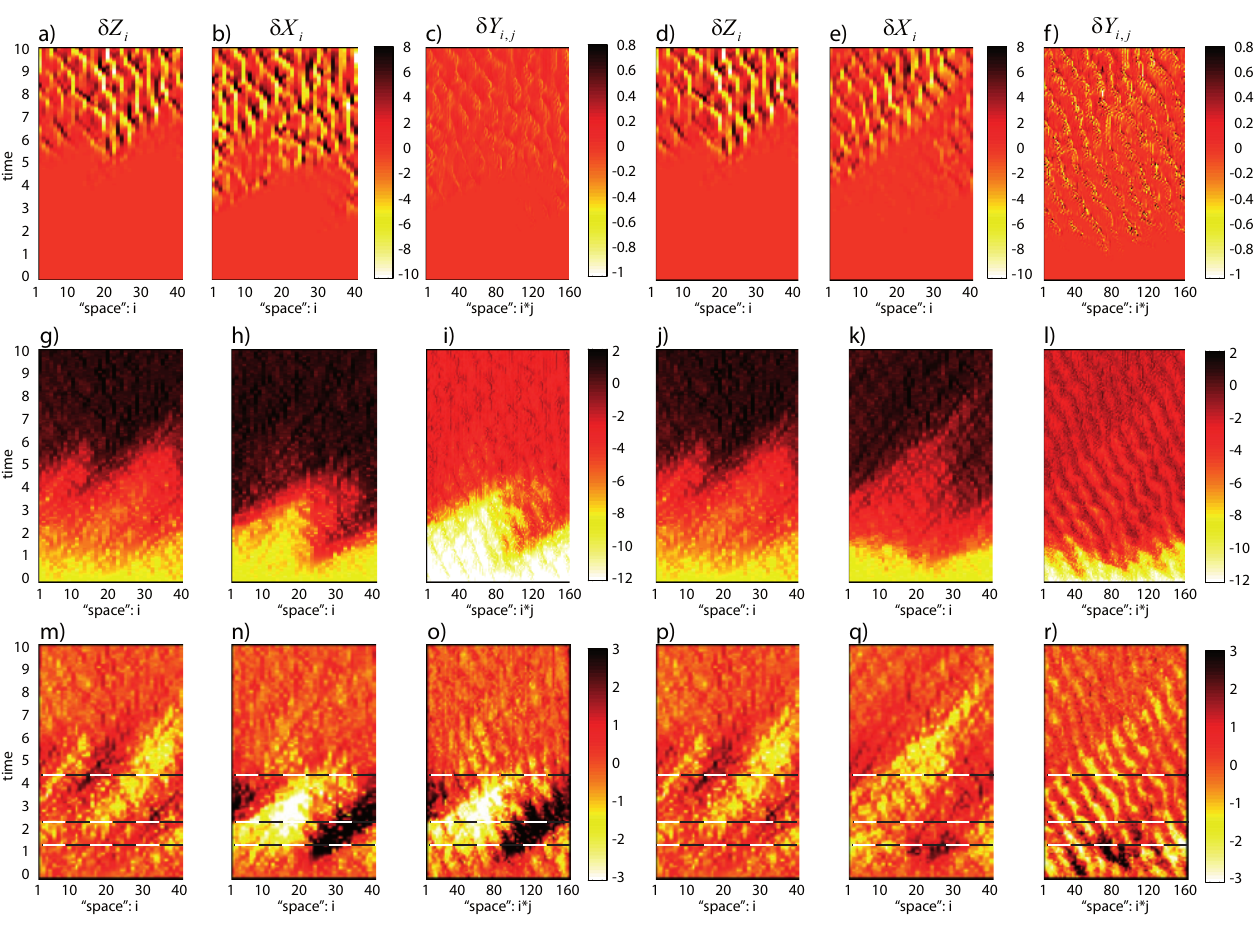
Fig. 3. Upper row: dynamics of a single realization of perturbations of the initial condition for (a, d) the simplified L96 model, and (b, c) the slow-fast variables, δx i and δy j,i of the L96 model with weak coupling h =0.3 and (e, f) with strong coupling h =1. The initial perturbations were randomly chosen according to a Gaussian distribution with standard deviation σ for δz and δx , and 0 for δy . Middle row: the same as in the upper row but in logarithmic scale. Lower row: the same as in the middle row but taking away the mean at each time. In order to ease their comparison, panels a, g, m are respectively identical to panels (d, j, p) . Notice also the different scales in each